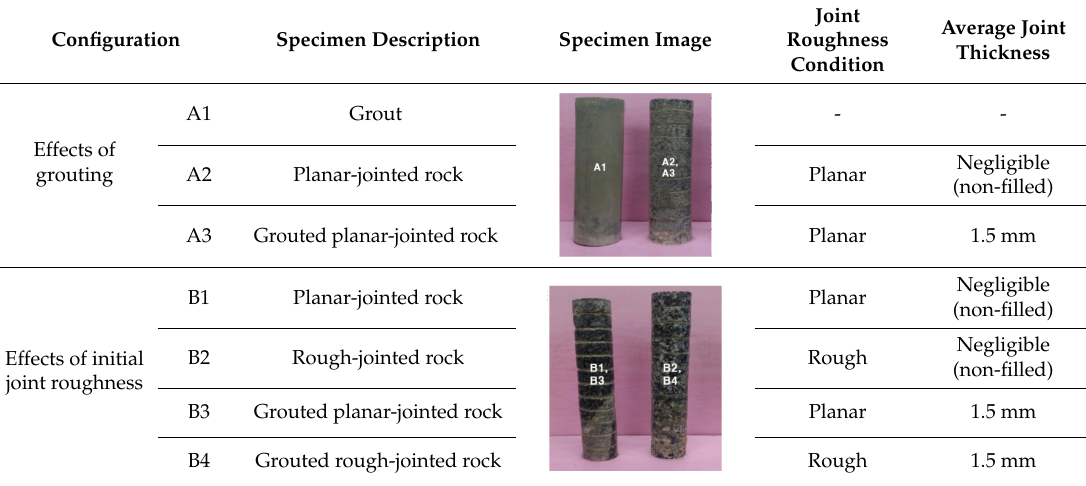
Table 2. Experimental cases for grout and rock specimens tested in this